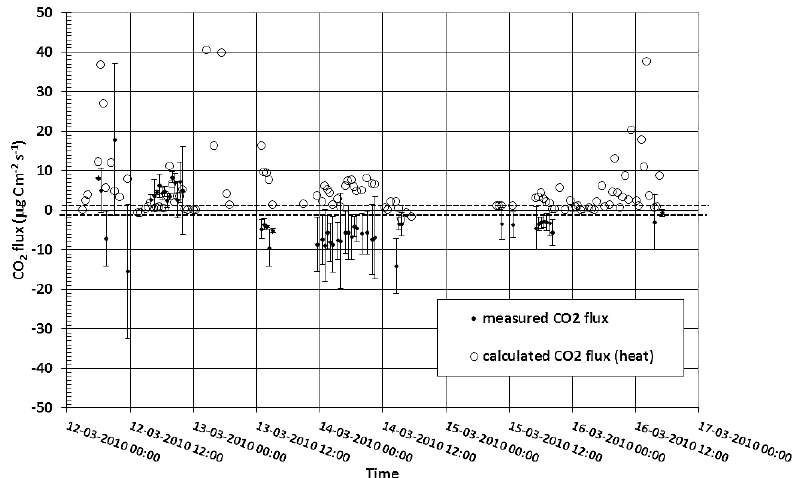
Fig. 8. The measured fluxes and the calculated fluxes using varying concentration based on brine volume calculated from ice temperature and Rc using the heat flux parameterization of Rc (o) as in Fig. 7. The CO 2 flux is estimated from EC technique, the cospectra peak method and the dissipation method. The dot shows the mean of the three methods and the bar shows the standard deviation.